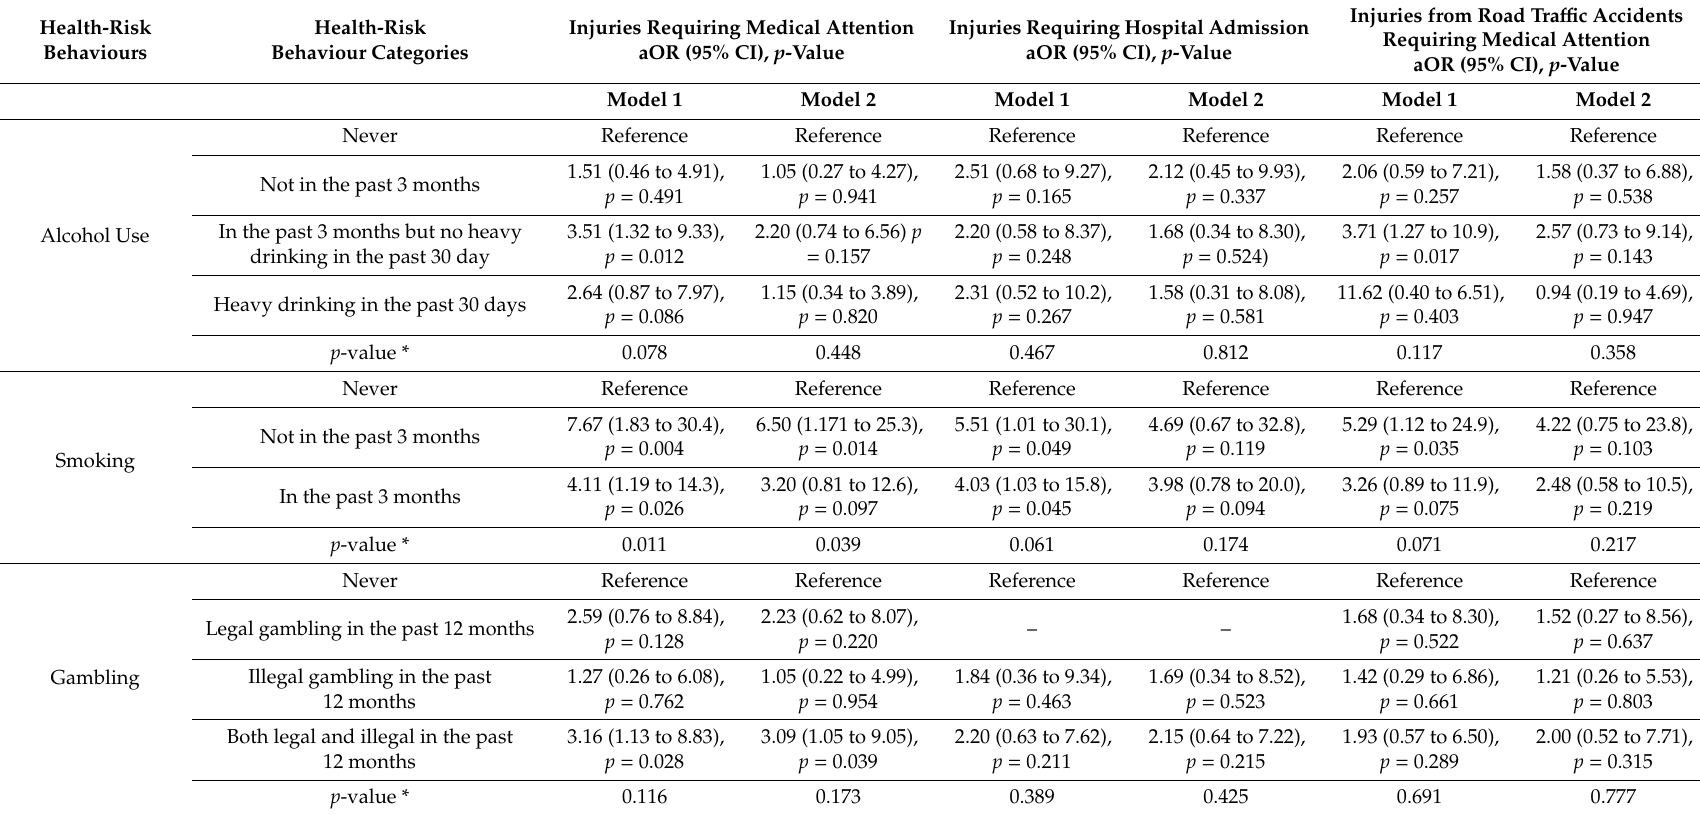
Table 3. Associations between health-risk behaviours and